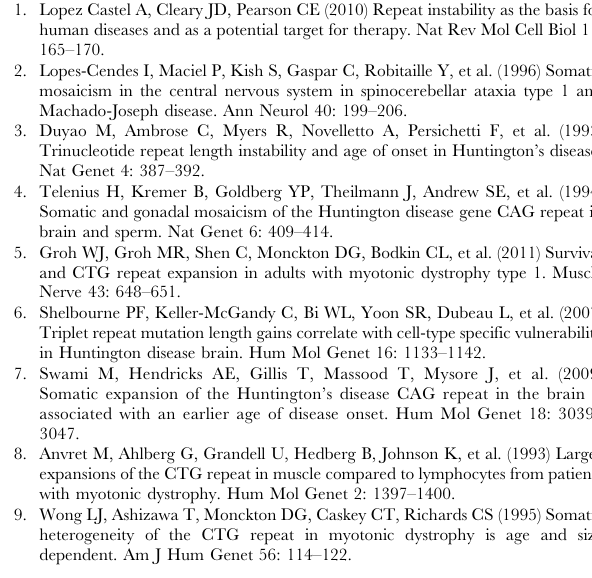
Figure S2 Sequence of primers used for ChIP experiments and quantitative RT-PCR. Figure S3 HD transgene expression in R6/1 and R6/2 striatum and cerebellum according to age. The same samples as shown in Figure 5A were analyzed, except that expression data were normalized to 18S . Transgene expression was assessed using the primers upstream of CAG repeats. Figure S4 A. Real time quantitative amplification of CAG expansion using DNA prepared from striatum and cerebellum of R6/1 and R6/2 mice of 6 weeks of age as standards. Upper panel. Profiles showing that the CAG primers amplify a specific product in